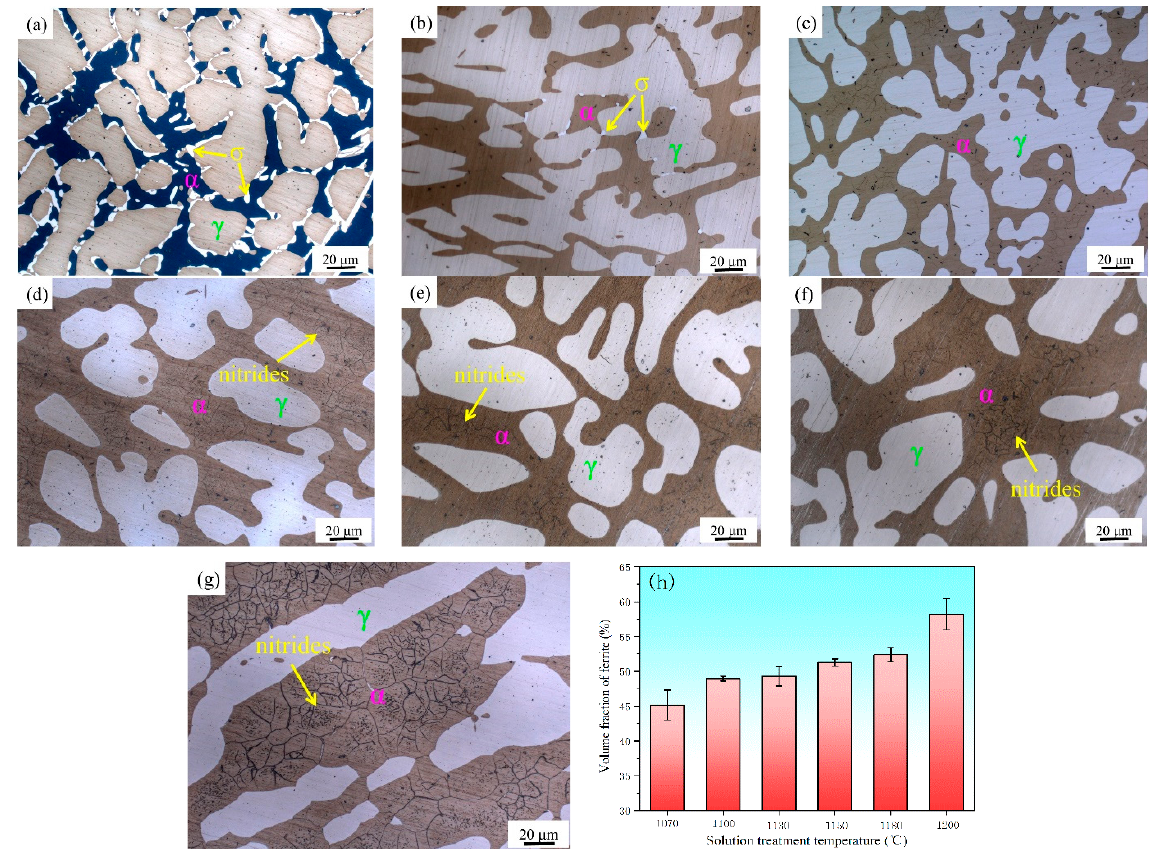
Figure 2. Microstructural evolution of samples with different solution treatment temperatures at: ( a ) 1040 °C; ( b ) 1070 °C; ( c ) 1100 °C; ( d ) 1130 °C; ( e ) 1150 °C; ( f ) 1180 °C; and ( g ) 1200 °C; ( h ) volume fraction of α phase.